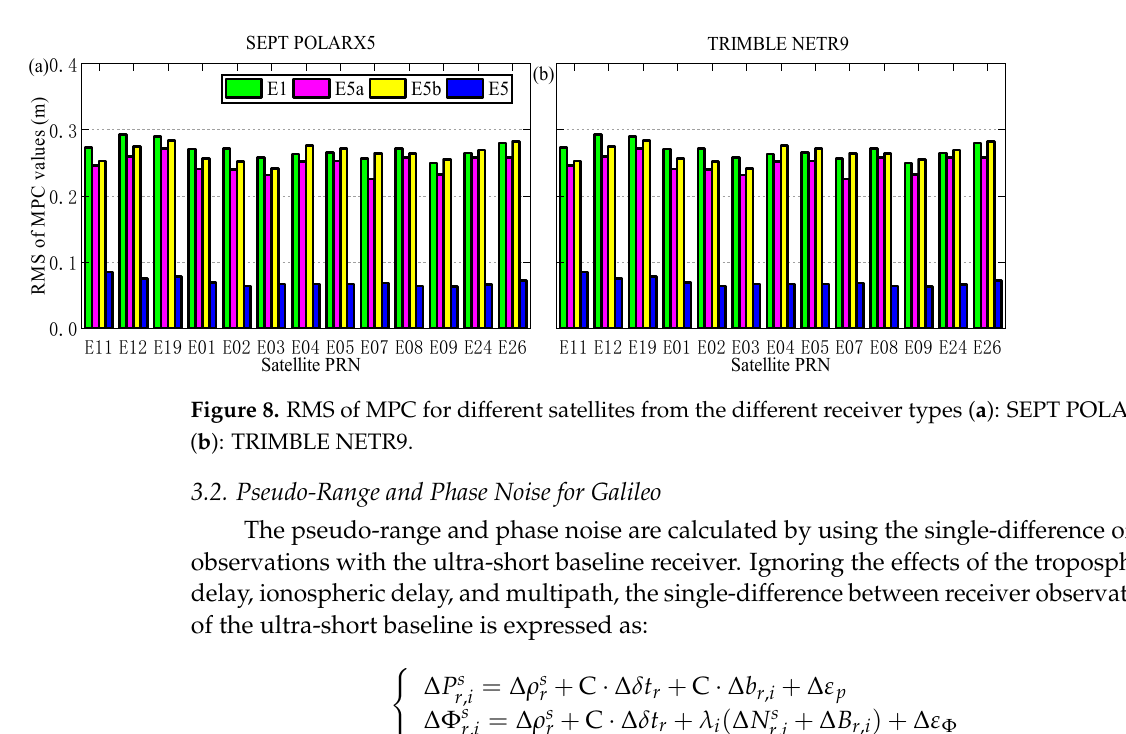
Figure 7. MPC values against satellite elevation at different frequencies for CUT0 station of Trimble NETR9 receiver ( a ): IOV-E12, ( b ): FOC-E04.